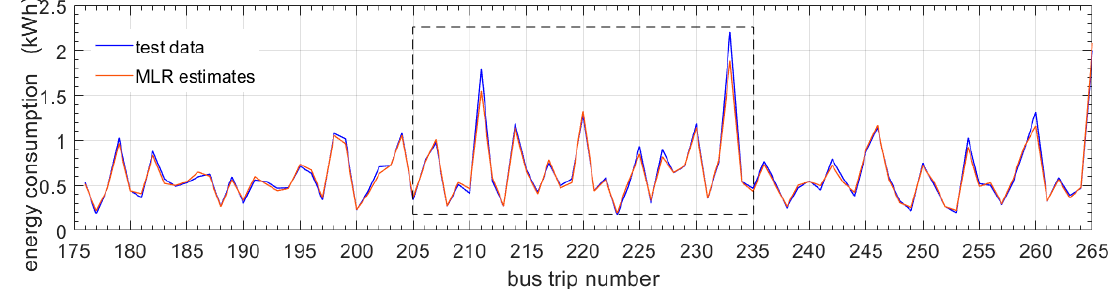
Figure 11. Test data and estimated values using the multiple regression (MLR) model.